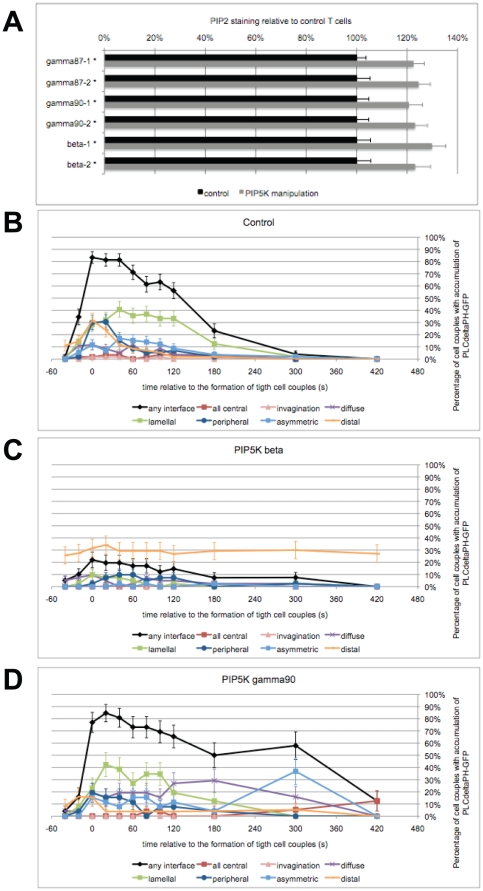
PIP5K overexpression alters PIP2 levels and localization.
A. PIP2 levels were determined by immunofluorescence staining of 5C.C7 T cells transduced with different GFP-tagged PIP5K isoforms as indicated. PIP2 levels of T cells with PIP5K overexpression (grey bars) and control (black bars) are normalized to control and are given with standard errors for two independent experiments each. An asterisks indicates statistical significance versus control with p<0.005. 100–200 cells were analyzed per experiment. A representative PIP2 staining experiment is shown as Fig. S2D. B. 5C.C7 T cells were transduced to express PLCδ PH-GFP and activated with CH27 APCs and 10 µM MCC agonist peptide. The graph shows the percentage of cell couples with standard errors that displayed accumulation of PLCδ PH-GFP with the indicated patterns [6] relative to tight cell coupling. 60 cell couples were analyzed. C, D. Similar to B, the panels show patterning data for 5C.C7 T cells expressing PLCδ PH-GFP with concurrent overexpression of PIP5K β (C) or γ90 (D). 41, 26 cell couples were analyzed per condition. Representative images for panels B–D are given in Fig. S2E–G. Representative movies have been published (γ87 [6]) or are given as Movies S4, S5, S6.